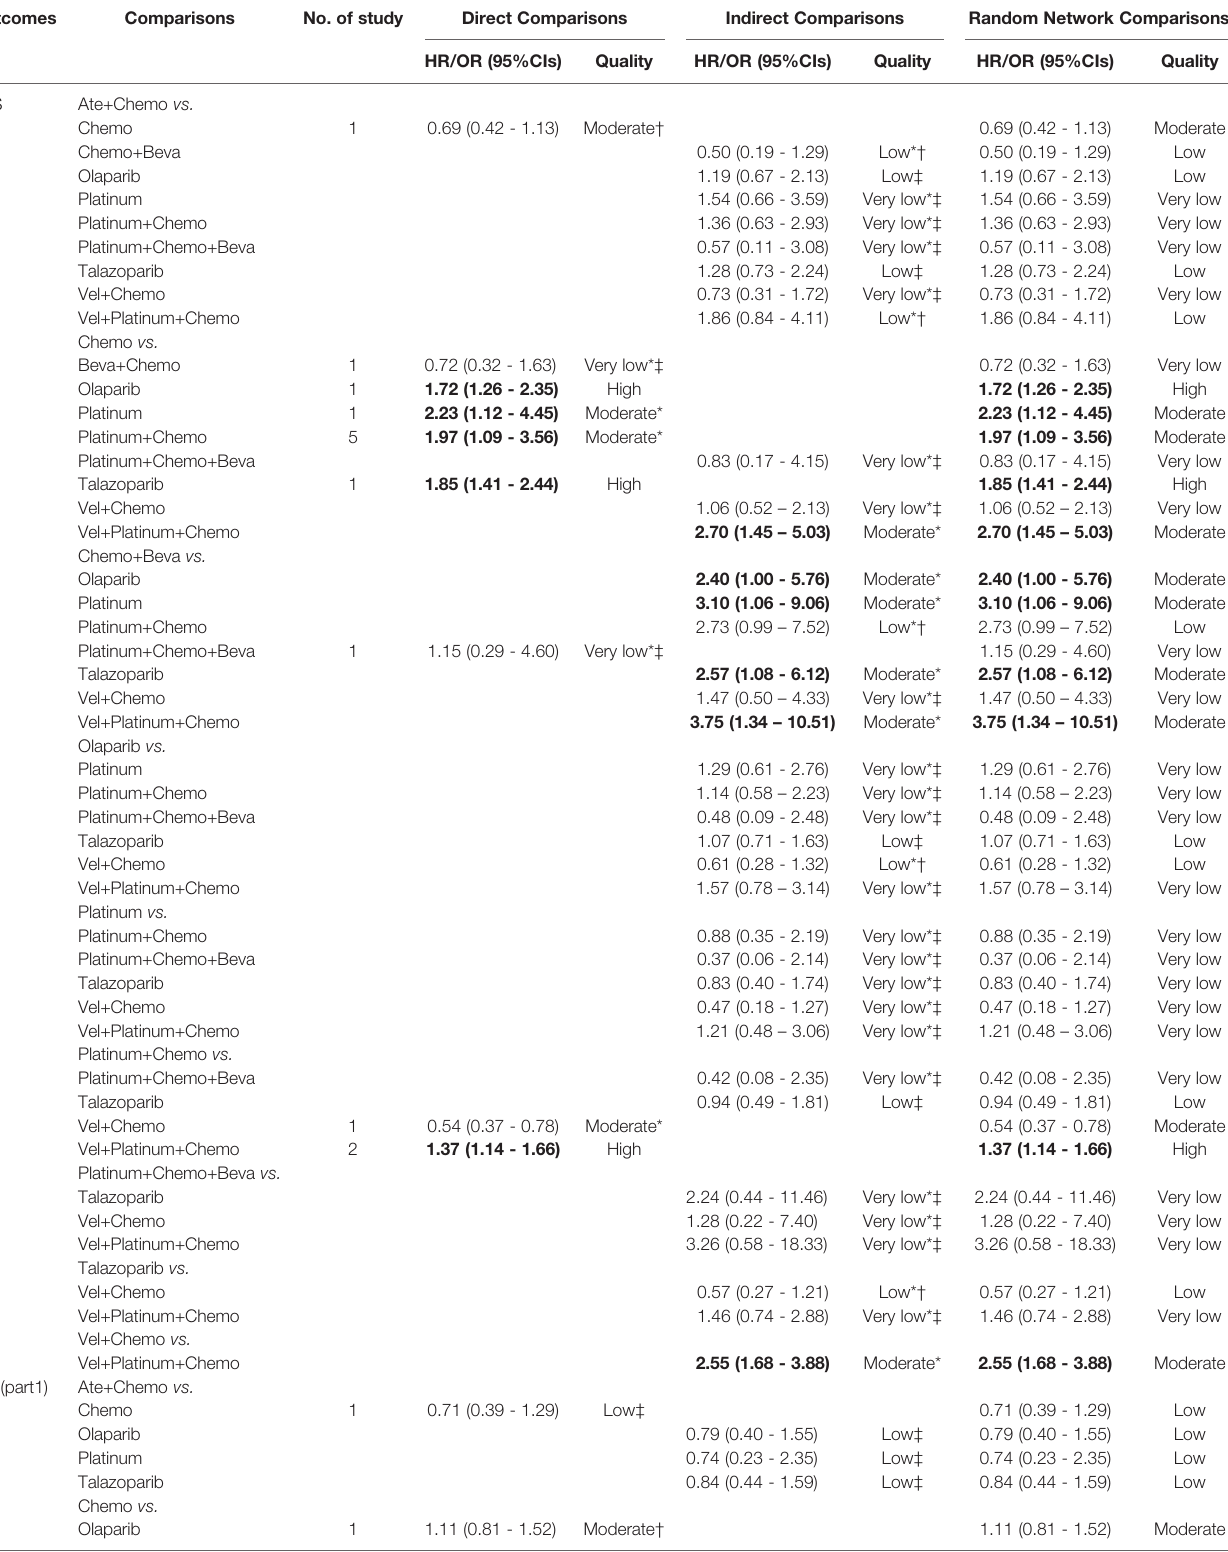
TABLE 2 | The results of therapeutic regimens according to their relative effect and reliability.